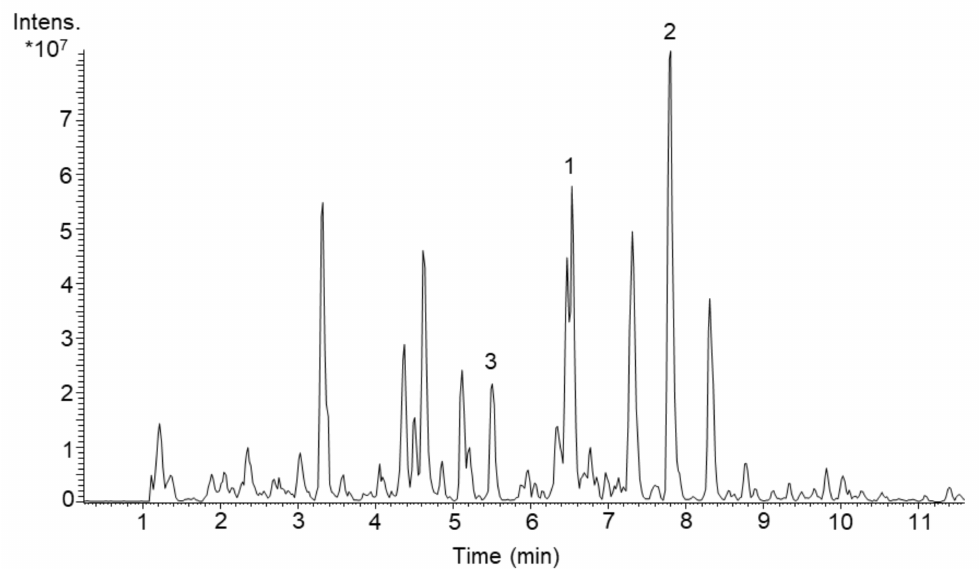
Figure 1. LC-MS chromatogram (RT 1–11 min out of overall 20 min analysis) of butanol extract of S. acidiscabies Lu19992 cultivated in DNPM medium. The peaks representing newly identified compounds are marked: ( 1 ) Scabimycin A, ( 2 ) Scabimycin B, ( 3 ) Scabimycin C.